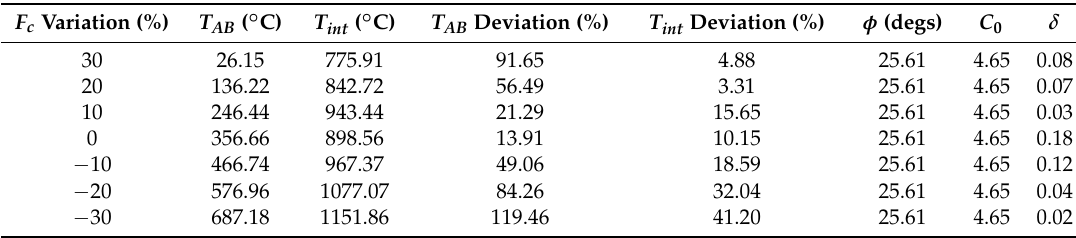
Table A1. Predicted temperatures and other variables with varying cutting force input under test 1 cutting condition.